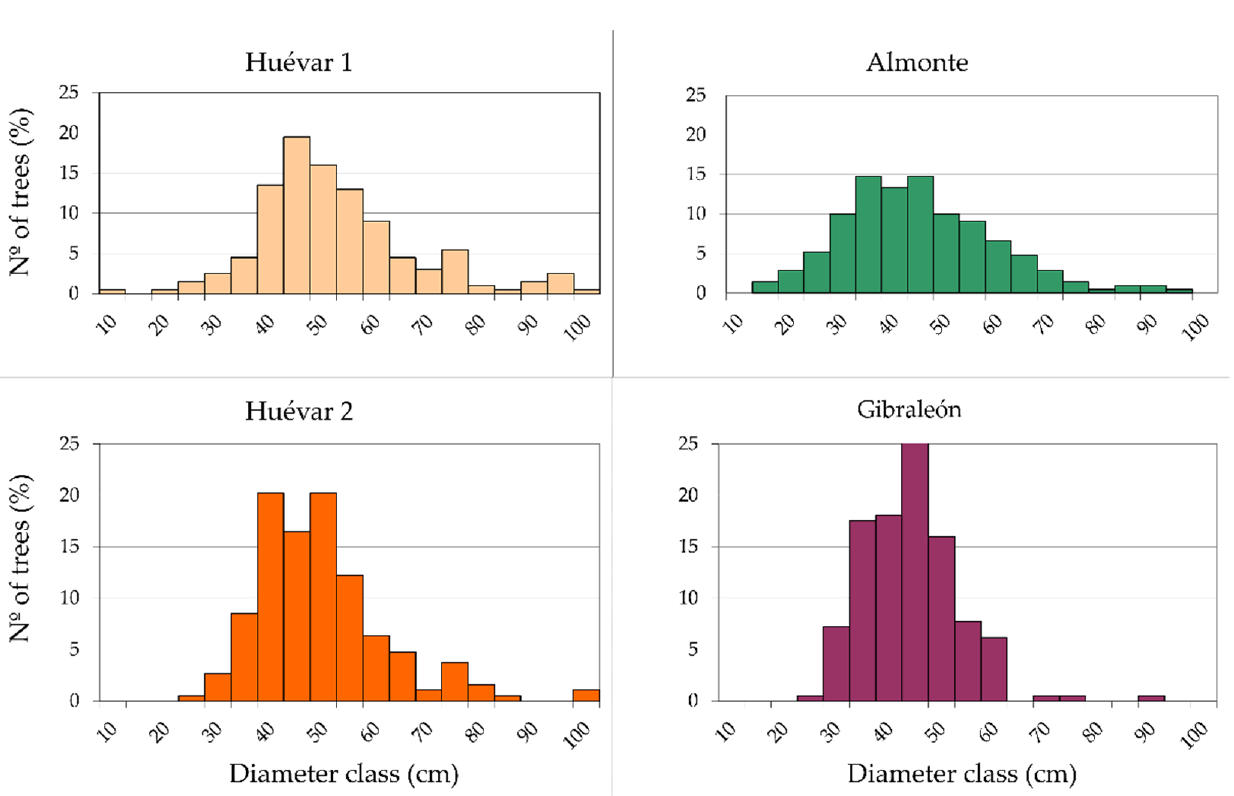
Figure A1. Frequency distributions of the 5 cm size classes for each cluster in the study area. Tree samples ( Q. ilex individuals/ Q. suber individuals): Huévar1, 101/99; Almonte, 1/206; Huévar2, 19/189; Gibraleón, 0/200).